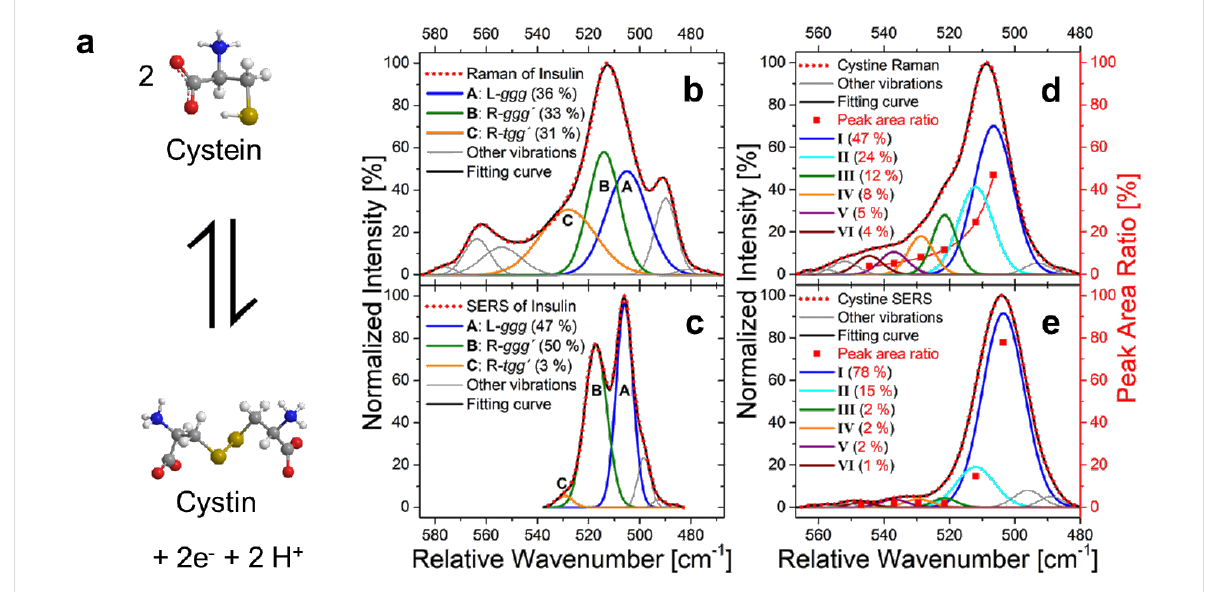
Figure 2: (a): Schematic representation of the dimerization redox equilibrium between cystein and cystin. (b) Normalized Raman and (c) SERS spectra of insulin deconvoluted by multiple Gaussians (disulfide stretching mode region). Relative experimental ratios of the Gaussian areas corres- ponding to the different S–S bond rotamers are indicated in brackets. (d) Normalized Raman (d) and SERS (e) spectra of cystine (disulfide stretching mode region, alkaline solutions). Relative Gaussian areas for the six different S–S bond conformations are indicated in brackets. Adapted from [36]. Copyright 2014